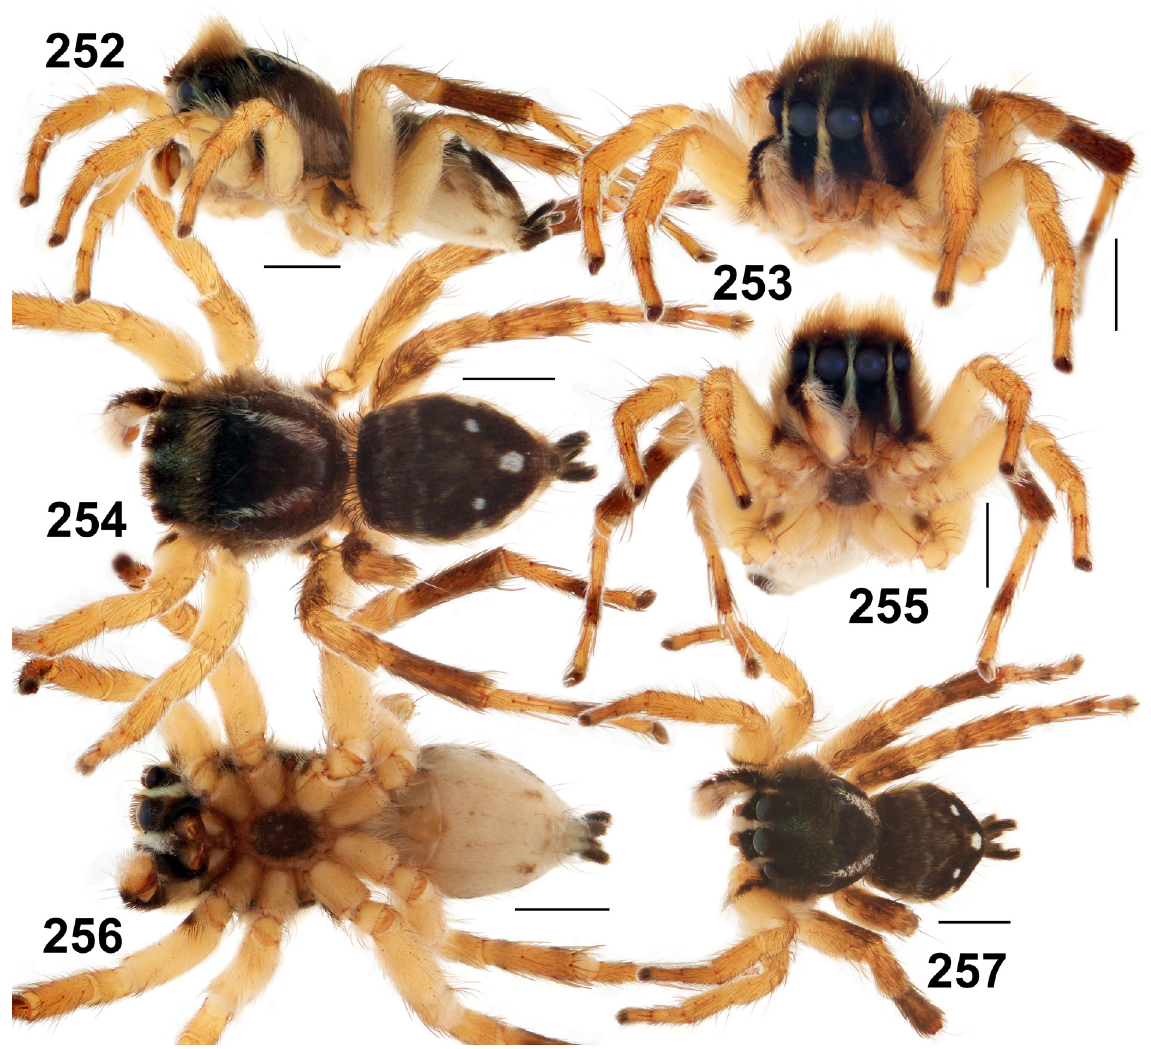
Figs 252–257. Stenaelurillus hirsutus Lessert, 1927 (holotype of Stenaelurillus cristatus Wesołowska & Russell-Smith, 2000) from Tanzania (Mkomazi GR), general appearance. Scale bars: 1